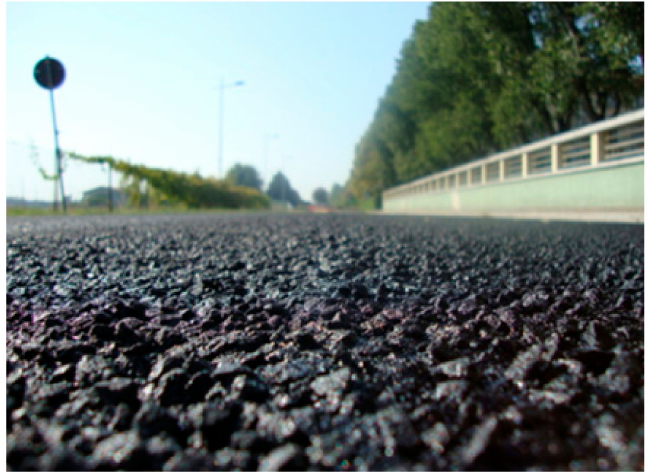
Figure 12. Cold laid acoustic microsurfacing at an Italian experimental site